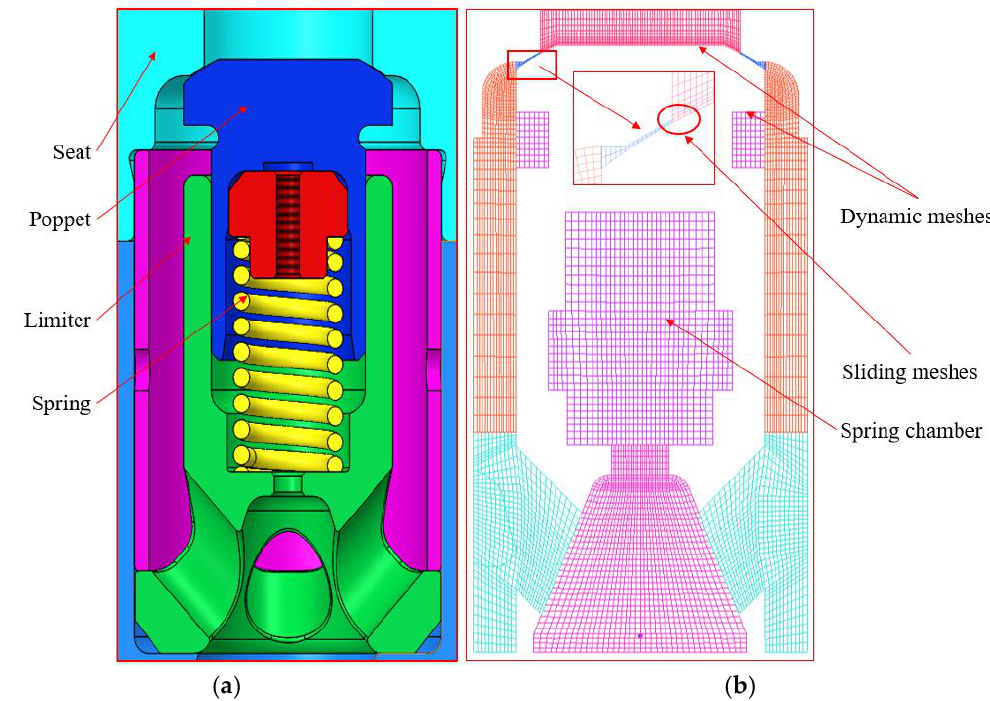
Figure 3. Meshes for the poppet valve. ( a ) Poppet valve; ( b ) meshes for the flow channel.